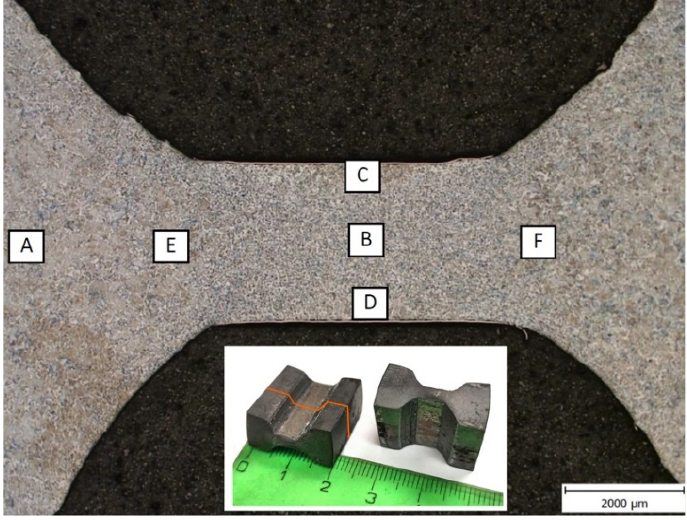
Figure 12. Marking of microstructure documentation sites (sample: variant 1). V1–V4 represent the areas of detailed microstructural analysis.